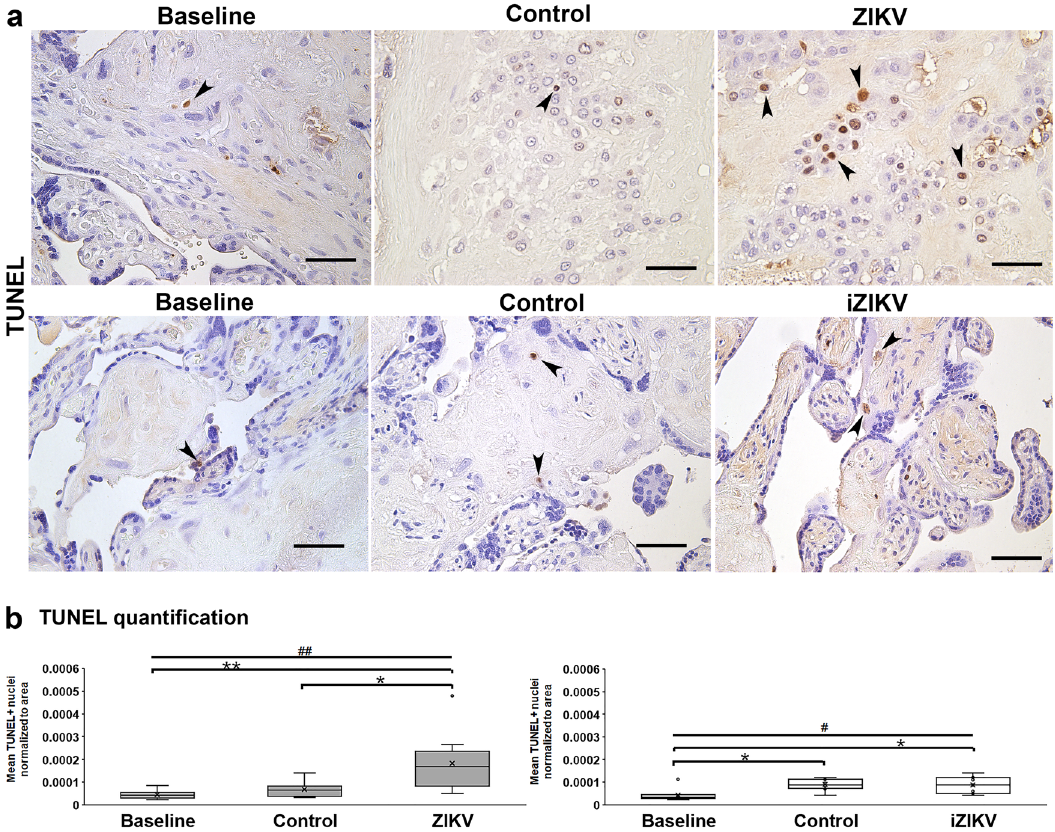
Fig. 6 Cell death elevated with ZIKV perfusion. a Representative TUNEL staining with DAB in Baseline, Control, ZIKV, and iZIKV exposed samples. TUNEL positive cells (arrowheads) appear as brown nuclei vs . blue nuclei counterstained with hematoxylin. Scale bars = 50 µ m. b Quanti fi cation of TUNEL positive nuclei normalized to the area of tissue within each fi eld analyzed. The left graph represents n = 10 and right graph n = 9 samples per condition. Box-plots represent the median in the centerline, upper and lower quartiles at top and bottom of box, min/max points as whiskers, outliers as dot, and the mean with x. # p < 0.005, ## p < 0.005 by one-way ANOVA. * p < 0.05, ** p < 0.005 by Tukey ’ s post hoc